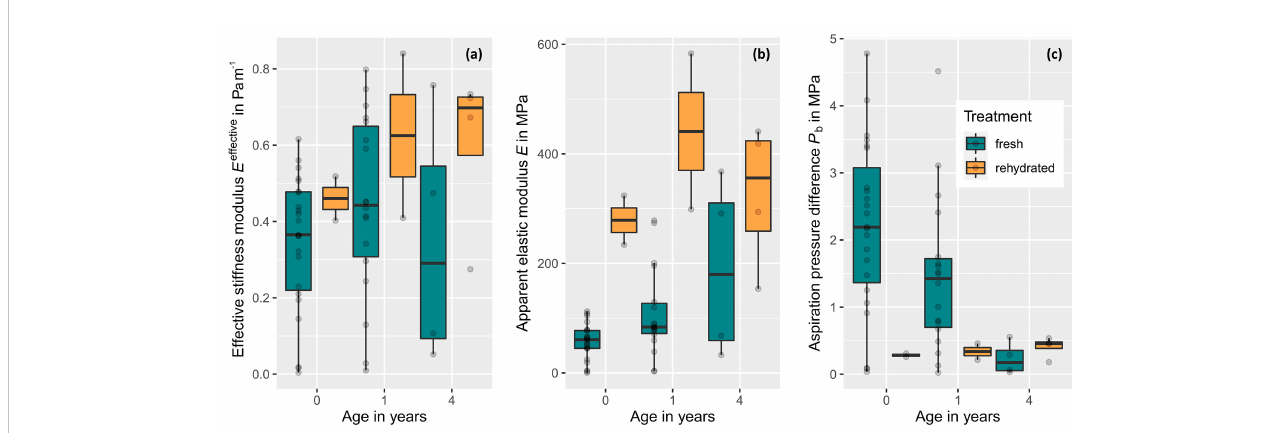
FIGURE 5 Stiffness parameters and aspiration pressure of intervessel pit membranes of Clematis vitalba for xylem with a different age and hydration status (fresh, never-dried pit membranes: age = 0 years ( ≙ current year, n = 23), 1 year (n = 18), and 4 years (n = 4) and dehydrated-rehydrated ones: age = 0 years ( ≙ current year, n = 2), 1 year (n = 2), and 4 years (n = 4).). (A) Effective stiffness modulus Eeffective,which is the only from the three parameters represented here, that is directly measured. (B) Apparent elastic modulus Eapparent, which represents a transformation of Eeffective by size and thickness t and thus is dependent on Eeffective. Differences in the pattern between both moduli are caused by size and thickness integration. For fresh membranes, thickness data were measured. For rehydrated ones, we used the value of fresh pit membranes with age = 4, assuming the thickness would be similar. Therefore, all dehydrated values in (B) are an approximation and do not represent valid, measured data. (C) Aspiration pressure Pb, which represents a rough estaimation based on Eapparent, membrane thickness t, and chamber depth l. For fresh pit membranes, Pb decreased signi fi cantly with